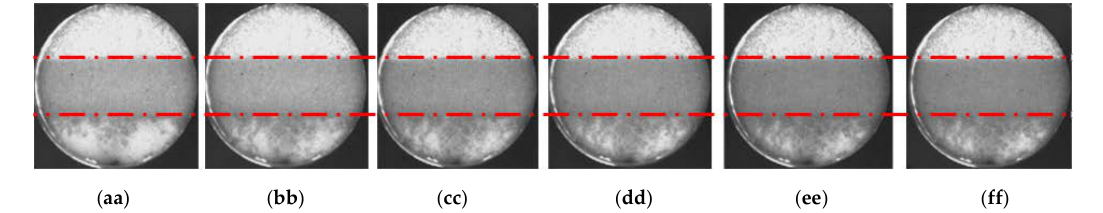
Figure 8. Gas–oil interface migration during CO 2 -assisted gravity drainage after increasing resistance. ( a ) 0.01 HCPV, ( b ) 0.03 HCPV, ( c ) 0.05 HCPV, ( d ) 0.07 HCPV, ( e ) 0.09 HCPV, ( f ) 0.11 HCPV, ( g ) 0.15 HCPV, ( h ) 0.20 HCPV, ( i ) 0.24 HCPV, ( j ) 0.27 HCPV, ( k ) 0.30 HCPV, ( l ) 0.33 HCPV, ( m ) 0.36 HCPV, ( n ) 0.39 HCPV, ( o ) 0.42 HCPV, ( p ) 0.45 HCPV, ( q ) 0.48 HCPV, ( r ) 0.51 HCPV, ( s ) 0.54 HCPV, ( t ) 0.56 HCPV, ( u ) 0.58 HCPV, ( v ) 0.60 HCPV, ( w ) 0.63 HCPV, ( x ) 0.66 HCPV, ( aa ) 0.69 HCPV, ( bb ) 0.72 HCPV, ( cc ) 0.75 HCPV, ( dd ) 0.78 HCPV, ( ee ) 1.14 HCPV, ( ff ) 1.55 HCPV. Note: The red dotted line is the interface between layers with different permeability; the yellow circle is the moment of light